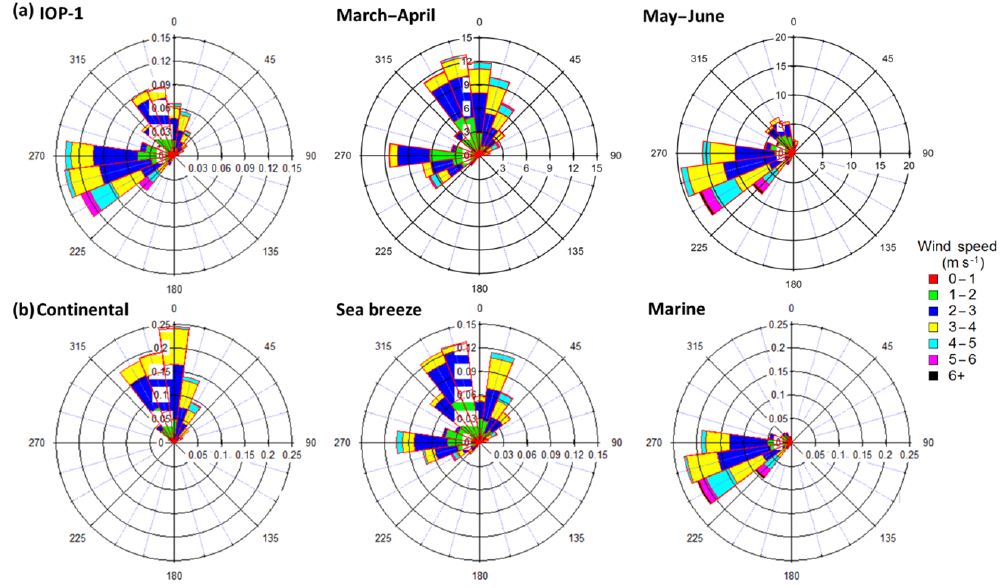
Figure 2. Rose plots of wind direction divided into 15 ◦ sectors and averaged over 30min (ACSM time step) with wind frequencies as radius (in %) and colored by wind speed intervals measured in Mbour for (a) the whole dataset and dry and wet months and (b) days classified as continental ( n = 17), sea breeze ( n = 29) and marine ( n =